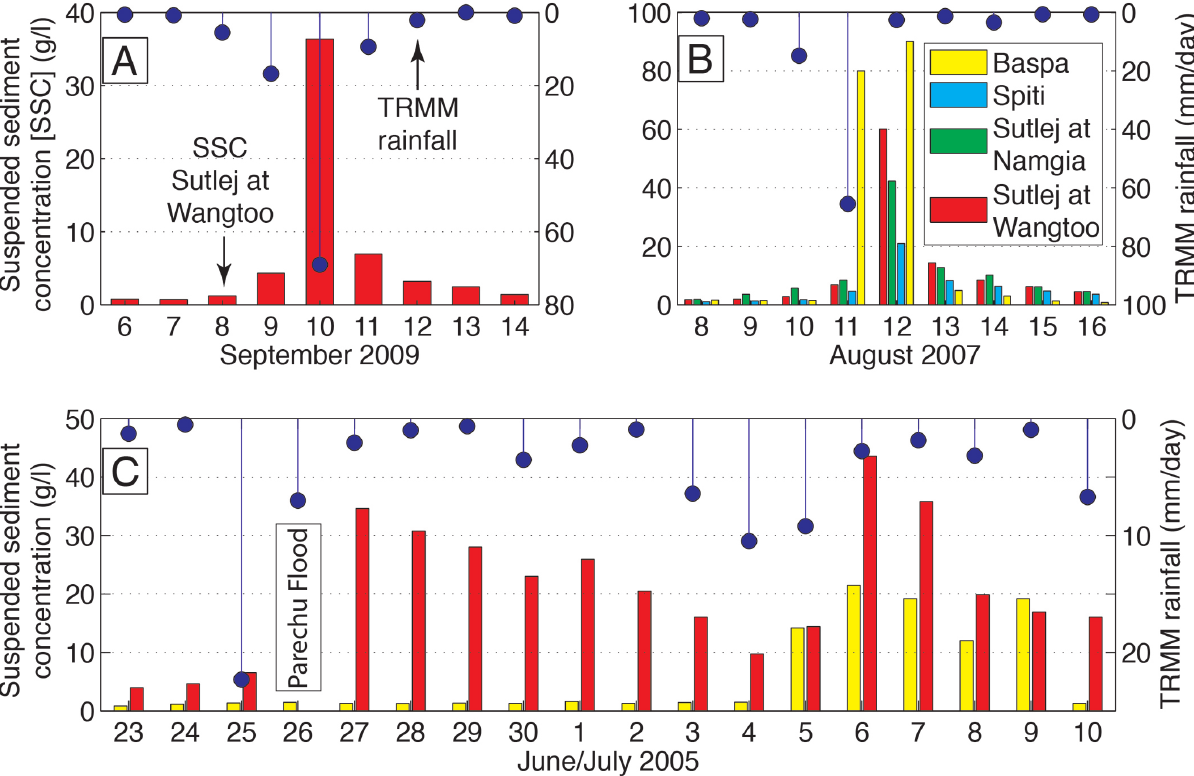
Fig. 6. Relation between peak SSC events and rainfall. (A) Peak SSC event triggered by a 2-day rainstorm ( > 90th percentile) during September 2009. Daily rainfall amounts are derived from TRMM 3B42 averaged over the Sutlej catchment at Wangtoo. (B) Peak SSC event caused by a synoptic rainstorm affecting several catchments in the Sutlej Valley during August 2007. Larger catchments (e.g. Spiti) show longer response times. Color coding indicates location of SSC measurements. (C) SSC response of the Sutlej River at Wangtoo to the lake outburst flood (Parechu Flood during June/July 2005) and a successive rainstorm, which especially affected SSC levels in the Baspa